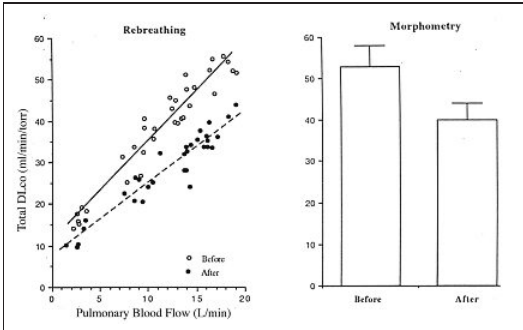
Effect of left pneu- monectomy in dogs on pulmonary diffus- ing capacity for CO, estimated physiologi- cally by rebreathing technique at increas- ing exercise intensi- ties measured by blood flow (left), and morphometrically (right) before and after pneumonec- tomy. Adapted from [32,